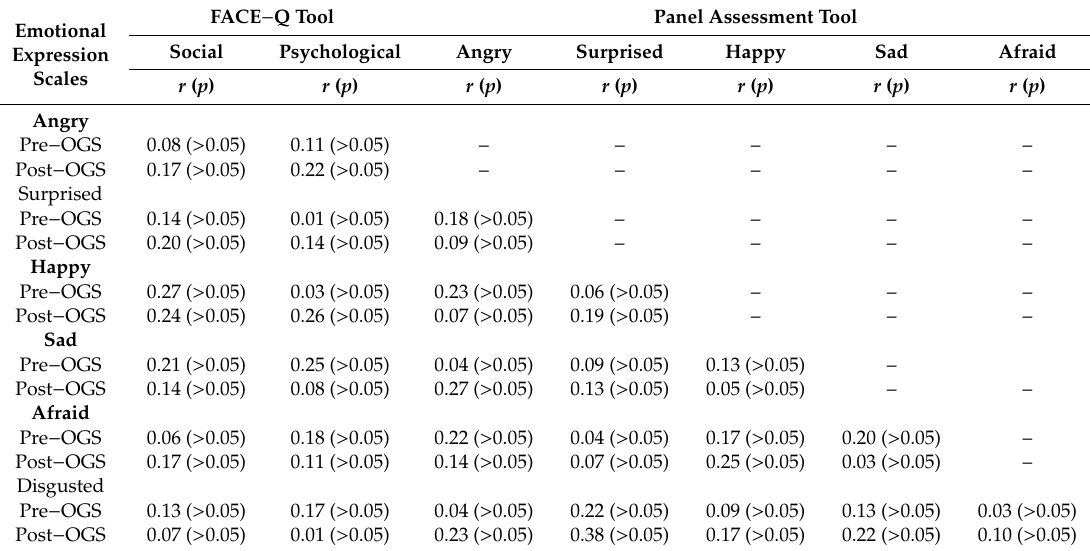
Table 8. Correlations for Pre − and Post − Orthognathic Surgery Assessment Scores of FACE − Q Quality of Life Scales and Lay − Observer − Based Panel Assessment of Emotional Expression